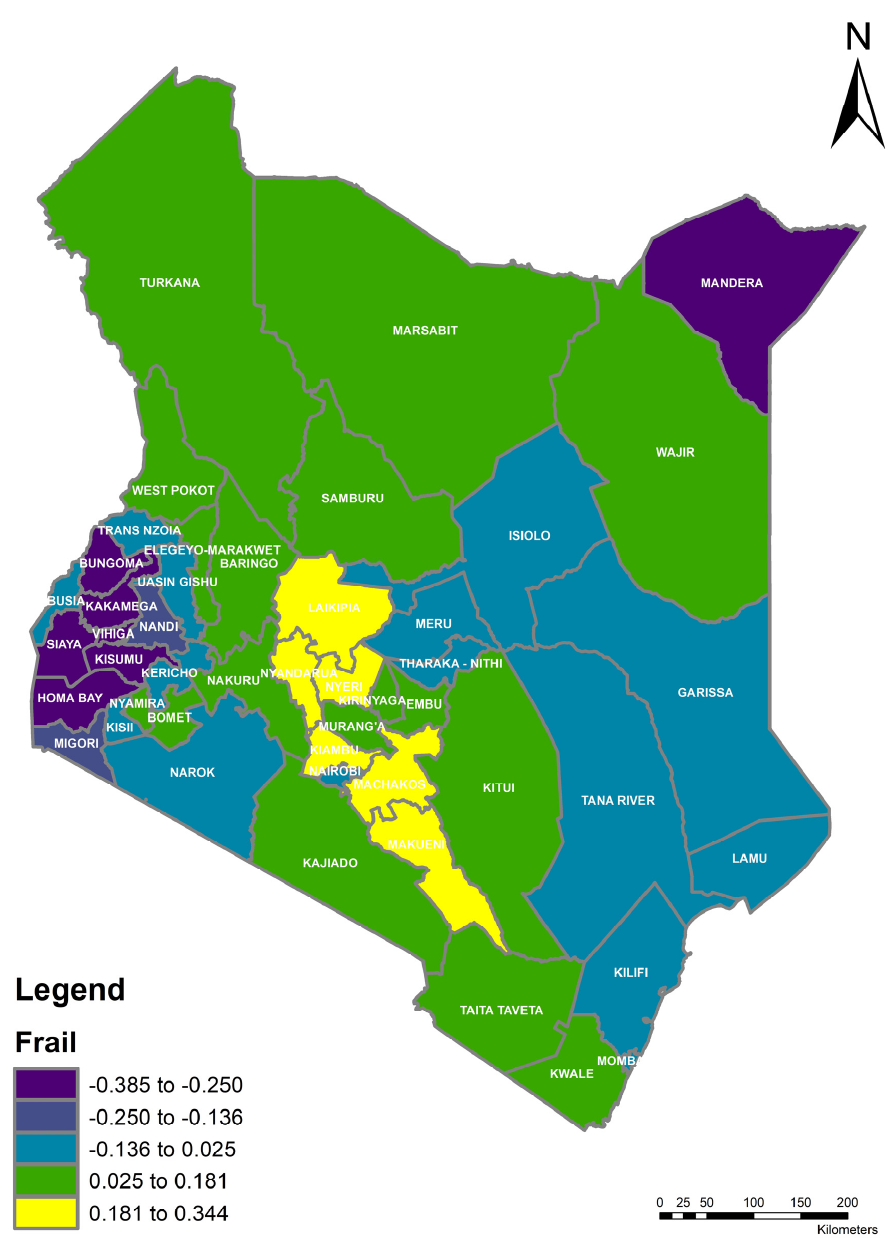
Figure 3. Map of posterior frailties. Kenya is a country in Africa on the East African region at (4.0889, 39.7707) divided in half by the